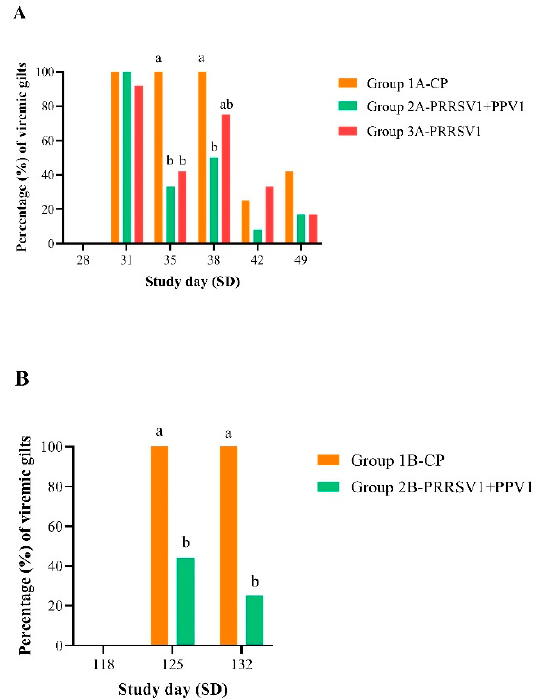
Figure 1. Proportion (%) of PRRSV RNA-positive gilts from challenge onwards in experiment A ( A ) and B ( B ). PRRS viral RNA load was assessed in sera using RT-qPCR. Frequency tables of positive results were generated and differences between groups were tested by Fisher's exact test. Different letters indicate statistical significance of differences between groups.